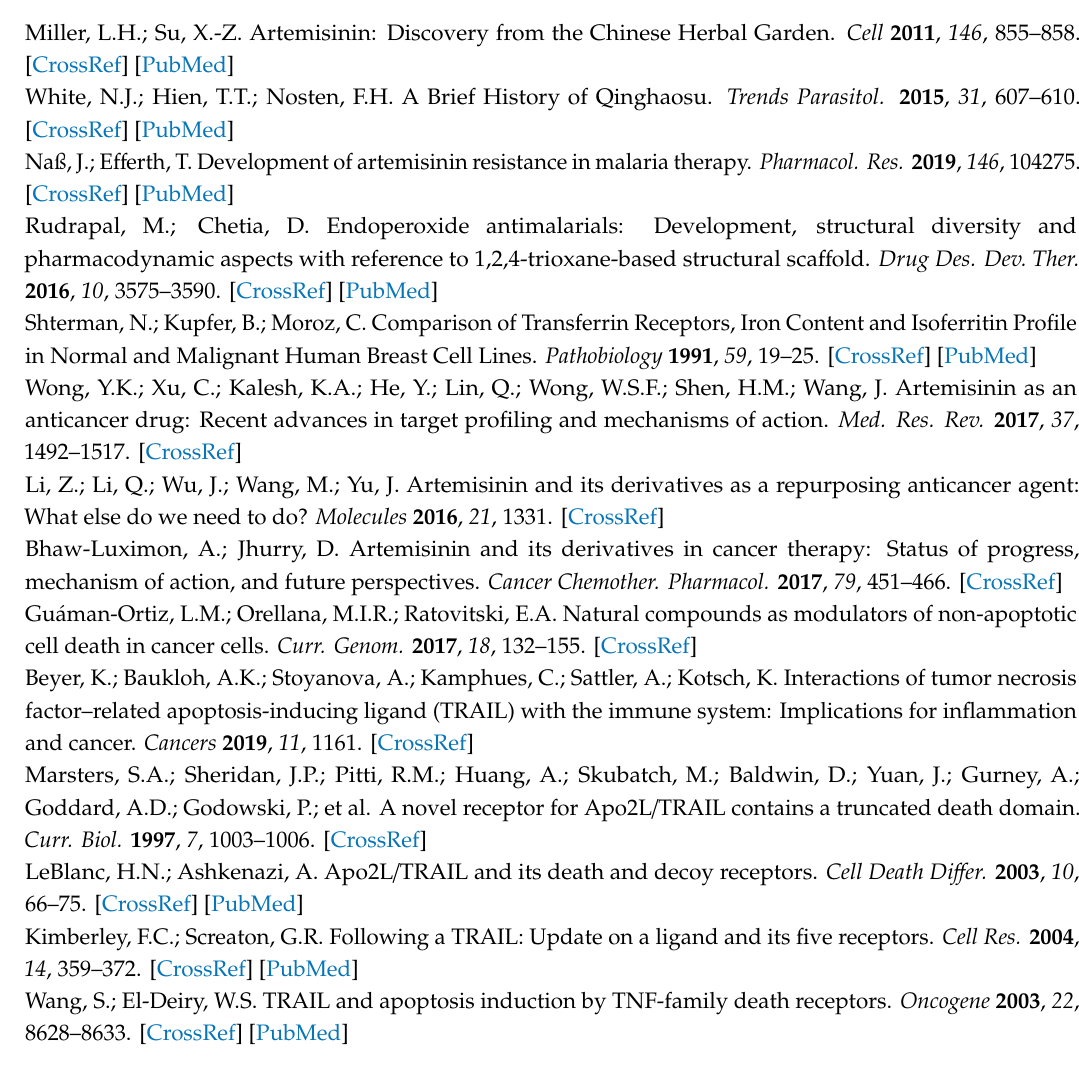
Table S1: List of primers used for qRT-PCR, Figure S1: The whole blot showing all the bands with molecular weight markers on the Western as the supplementary for Figures 4 and 6, Figure S2: The influence of DHA on p53 pathway in DLD-1, Figure S3: The whole blot showing all the bands with molecular weight markers on the Western as the supplementary for Figure 7, Figure S4: The 3D spheroids morphology changes under DHA treatment in HCT116 and